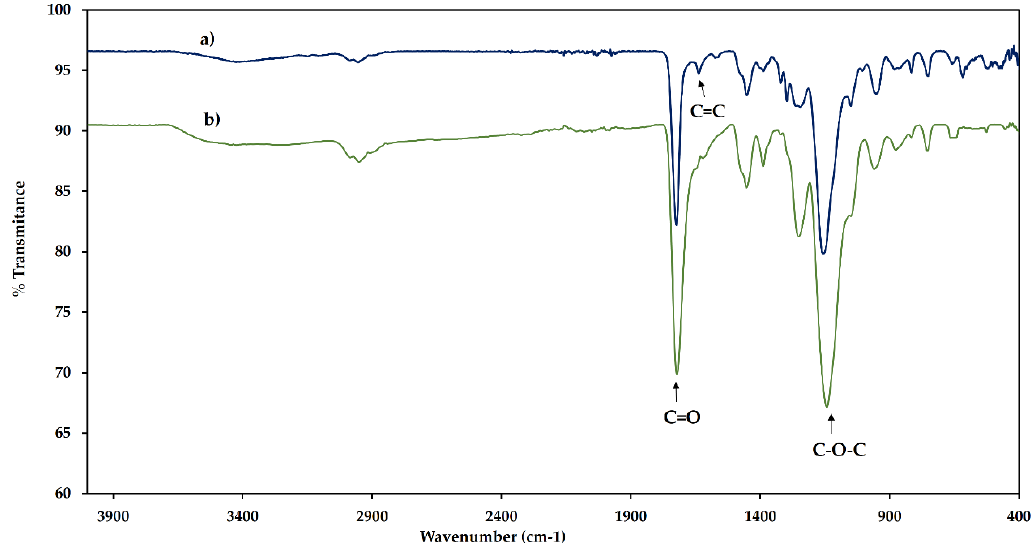
Figure 2. Fourier transform infrared (FT-IR) spectra of the synthesized polymers ( a ) poly(ionic liquid) ( b ) poly(methacrylic acid).